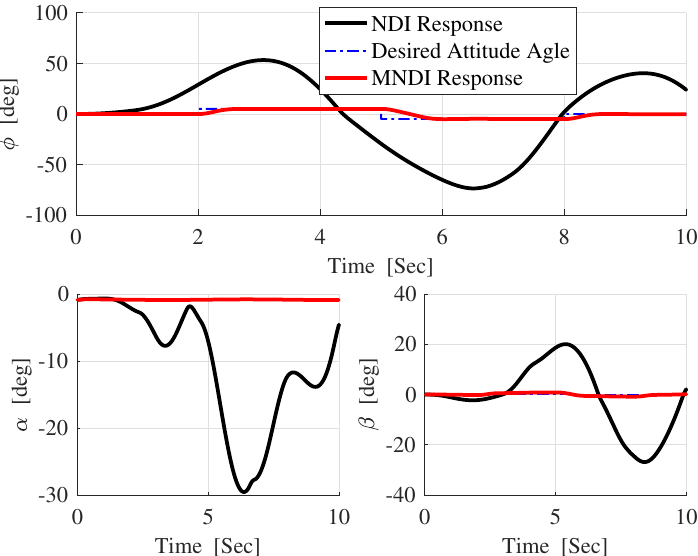
Figure 14. Attitudes response with NLDI and MNLDI with roll angle excitation with wind disturbances and uncertainties.